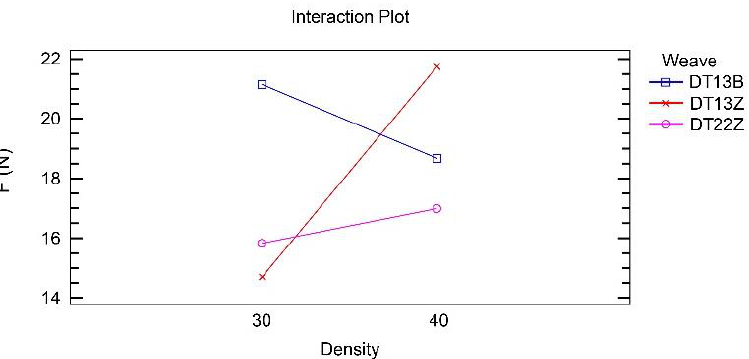
Figure 6. Interaction between density and weave in the analysis of the adhesion force for double fabrics for